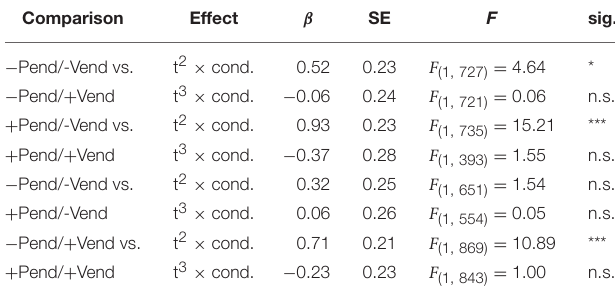
TABLE 4 | Eye-movement results of by-subject